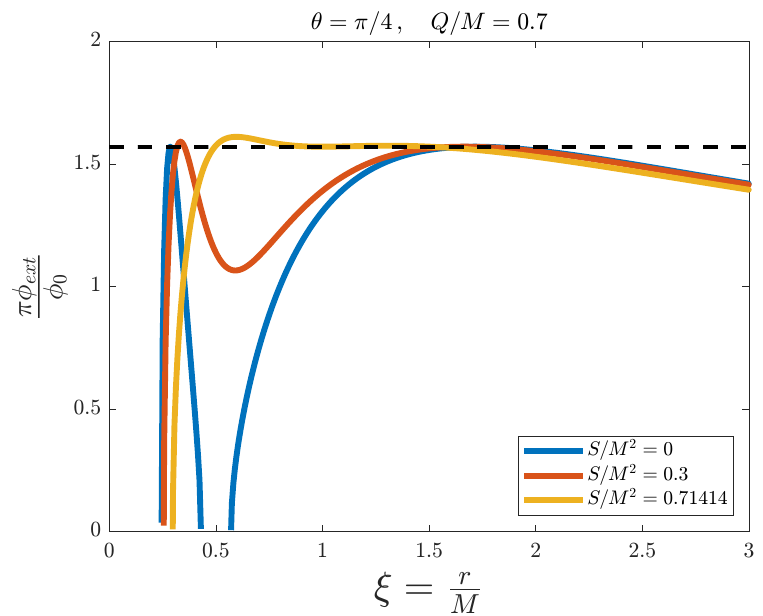
Figure 10. External magnetic flux πφ ext / φ 0 versus the adimensional distance ξ = r / M for the simulation of a Kerr–Newman black hole with fixed θ = π /4 and A = Q / M = 0.7, and for different values of B = S / M 2 . The dashed line represents the threshold value πφ ext / φ 0 = π /2.